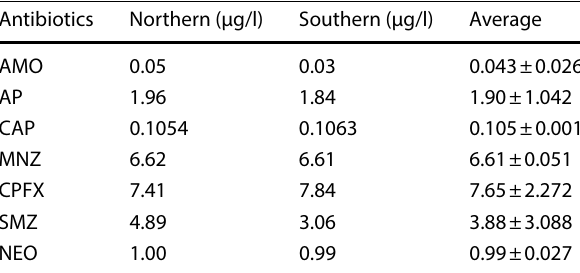
Table 3 Average concentration of antibiotic residues Antibiotics Northern (µg/l) Southern (µg/l)